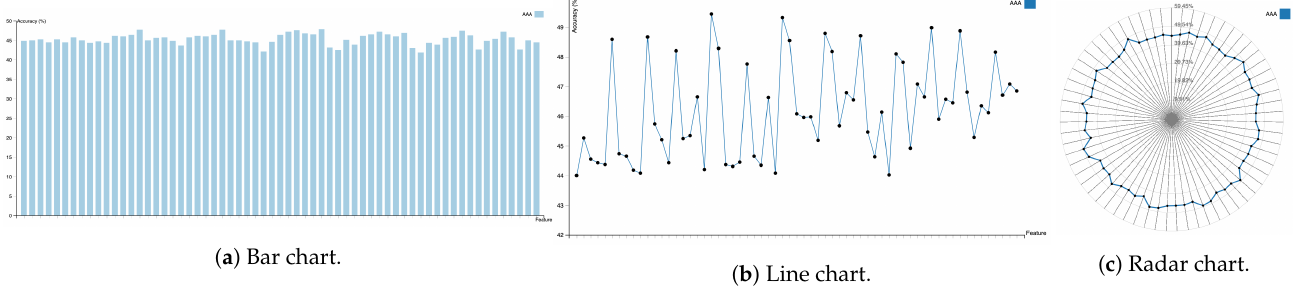
Figure 7. ML models based on the data set of 6 features are visualized using bar chart, line chart, and radar chart, respectively.